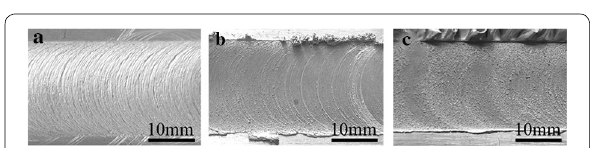
Figure 4 Effect of the tool rotating speed on the weld top surface: a 200 r/min; b 300 r/min; c 400